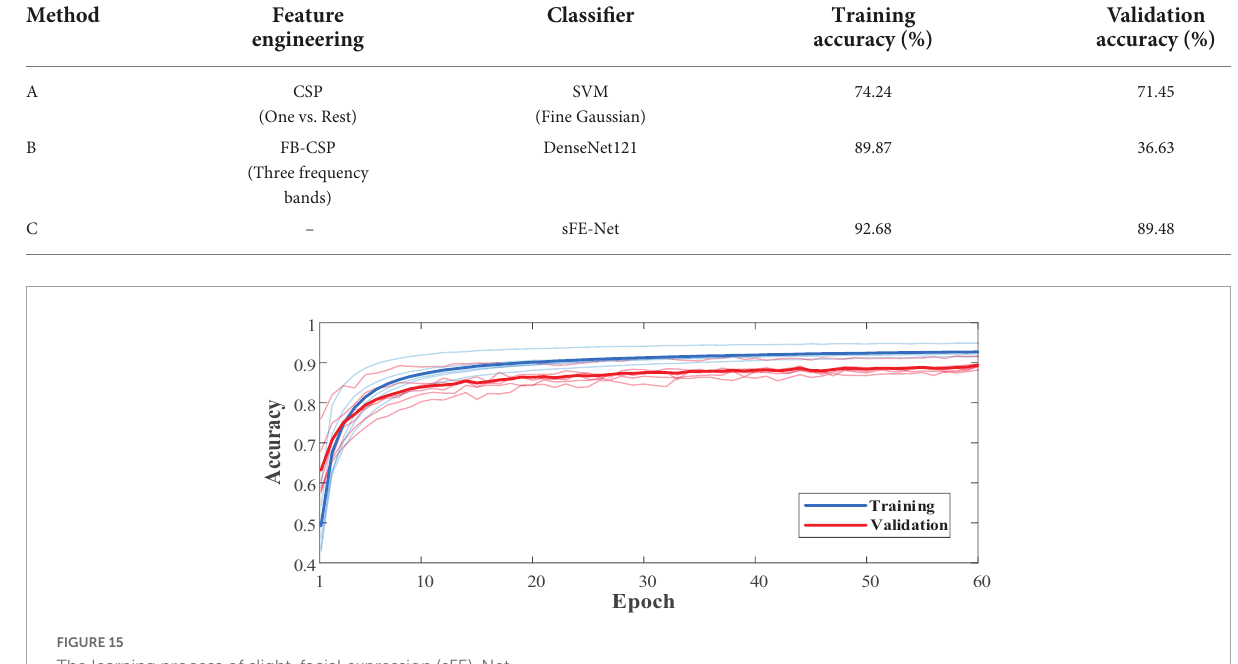
TABLE 11 Performance comparison for extra feature engineering.